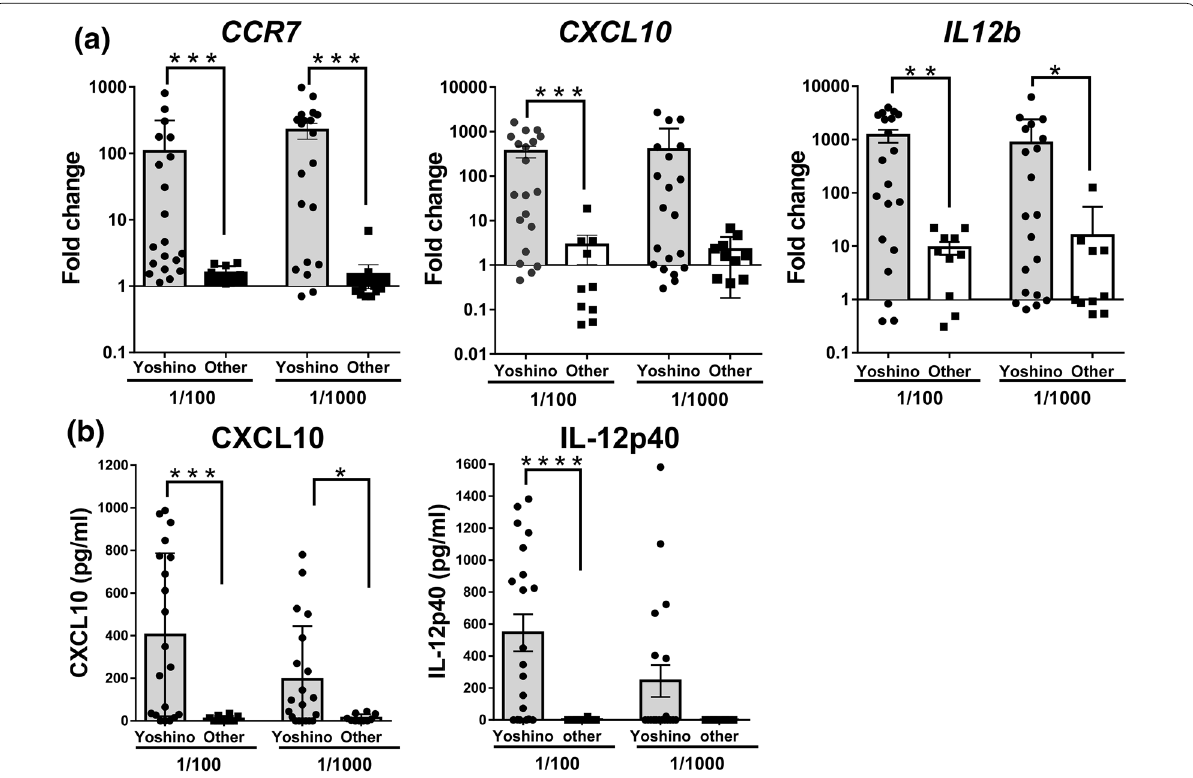
Fig. 1 Effect of Cryptomeria japonica on M1 macrophage polarization. a Gene expressions of the M1 macrophage markers CCR7, CXCL10, and IL12b in human‑derived macrophages stimulated by Cryptomeria japonica from Yoshino ( n inflammatory cytokines CXCL10, and IL‑12p40 from human‑derived macrophages stimulated by Cryptomeria japonica from Yoshino ( n other areas ( n 10). Data are the mean standard error of the mean. * P < 0.05, *** P < 0.001 (Mann–Whitney U = ±